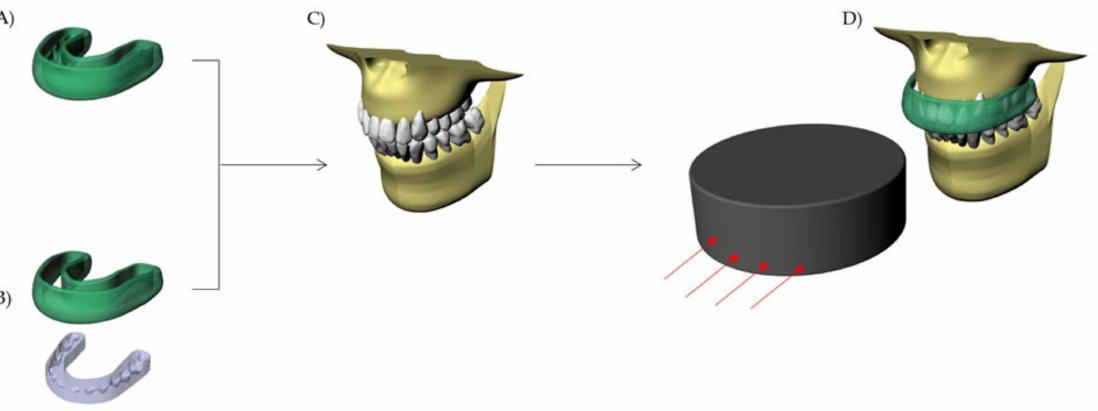
Figure 2. Schematic illustration of the evaluated MGs: ( A ) Conventional custom-made mouthguard; and ( B ) Hybrid mouthguard (HMG) device with combined occlusal splint and flexible axial flanges. ( C ) Maxillary model without MG and ( D ) MG in position with hockey puck impact